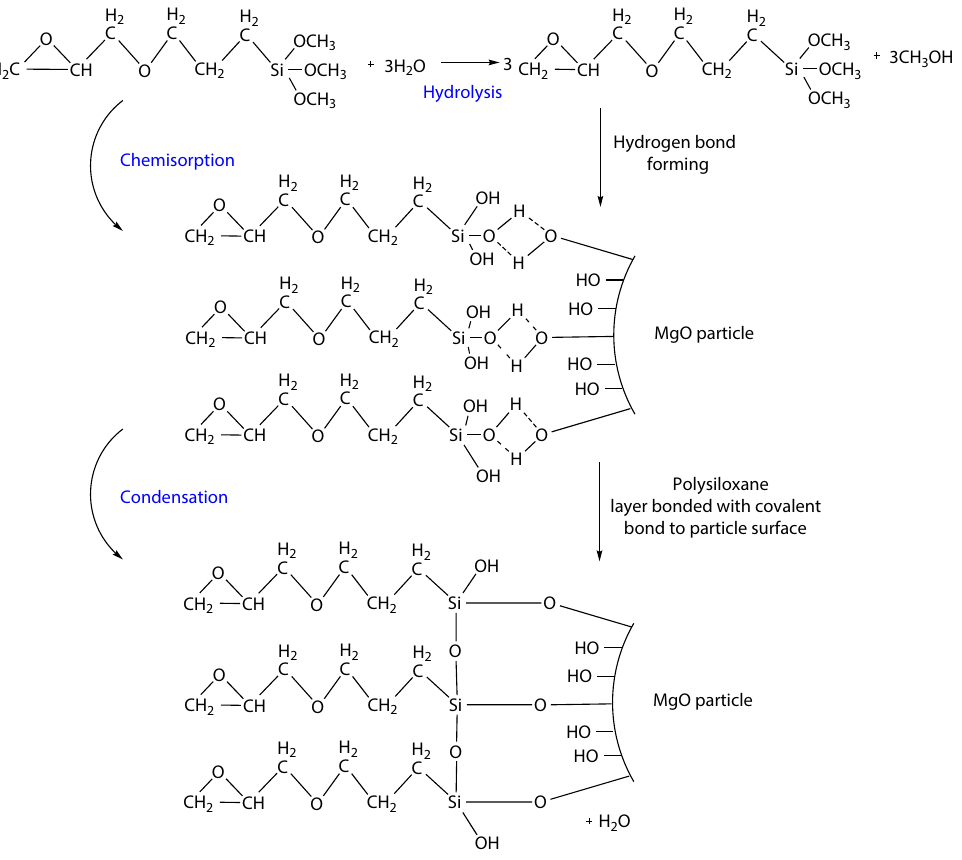
Figure 6. Simplified illustration of reaction of γ -Glycidoxypropyltrimethoxysilane with magnesium oxide surface (Redrawn and adepted from: